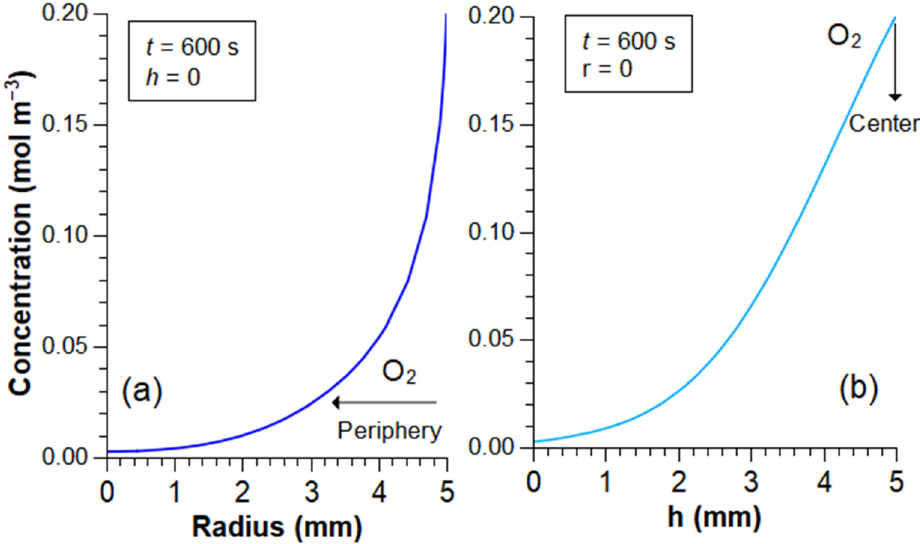
Figure 6. Concentration profiles for oxygen diffusion through the Evan’s drop. ( a ) From the center on the horizontal axis to the drop’s periphery. ( b ) From the center of the drop to the solution/air interface.